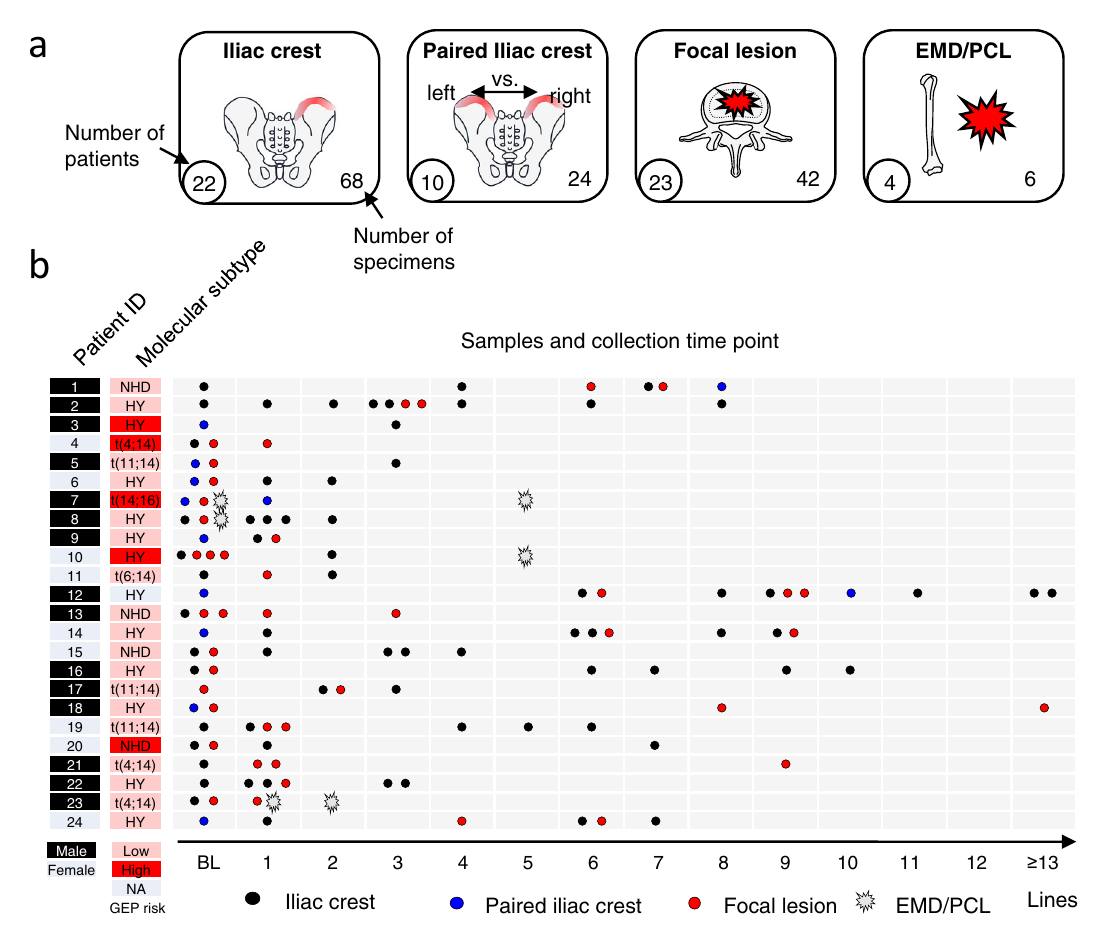
Fig. 1 | Patient characteristics, sample origin, and collection time points. In a the origin (redmarking)and the numberof investigated samples aredepicted.In b gender, molecular subtype, risk according to the GEP70 19 , as well as the typeof samples, and the time points of sample collection are shown.